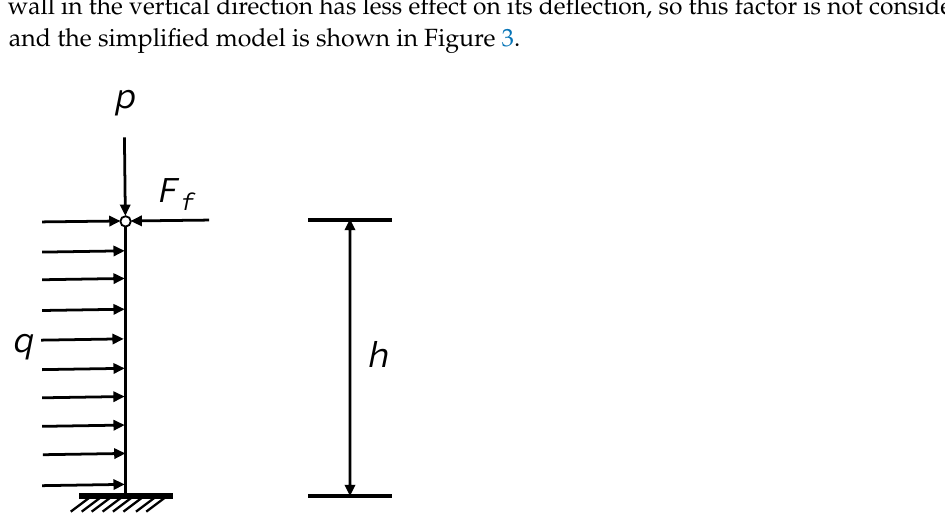
Figure 3. Simplified mechanical model. q -the set of horizontal loads; F f -frictional resistance between the coal seam and the roof plate, N; P -top plate pressure, Mpa; h -mining height,